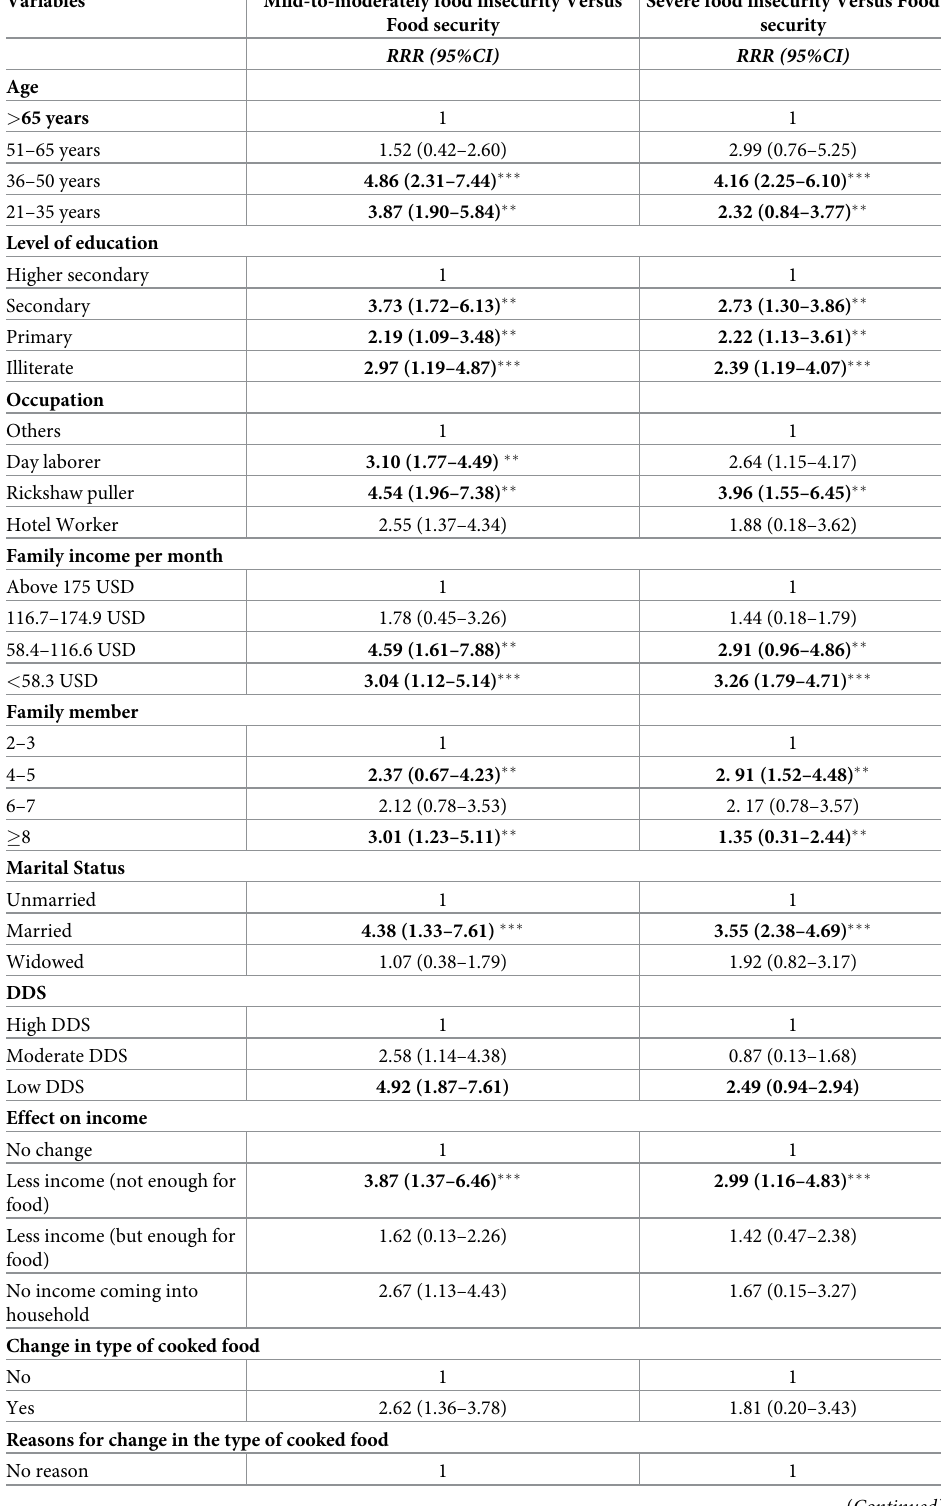
Table 4. Multivariate logit regression model results for the determinants of household food